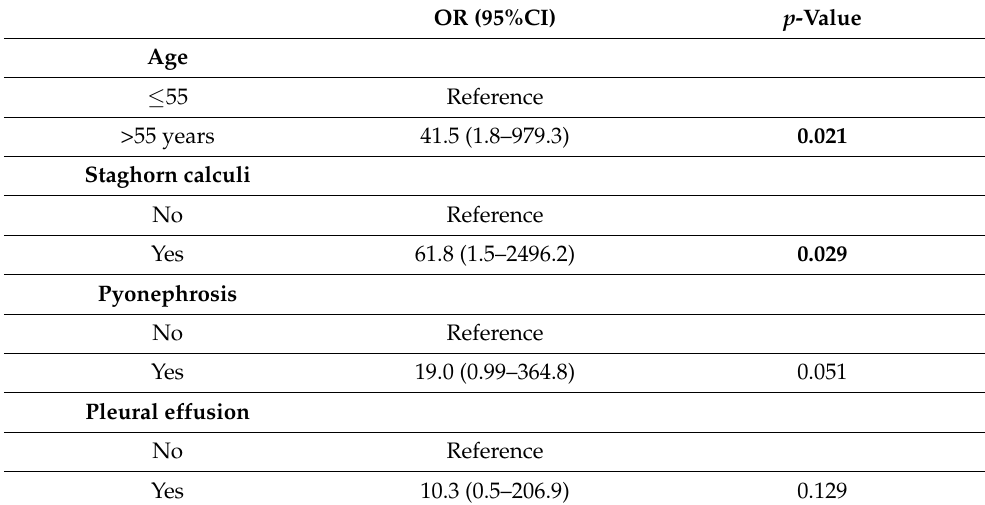
Table 3. Multivariate analysis of